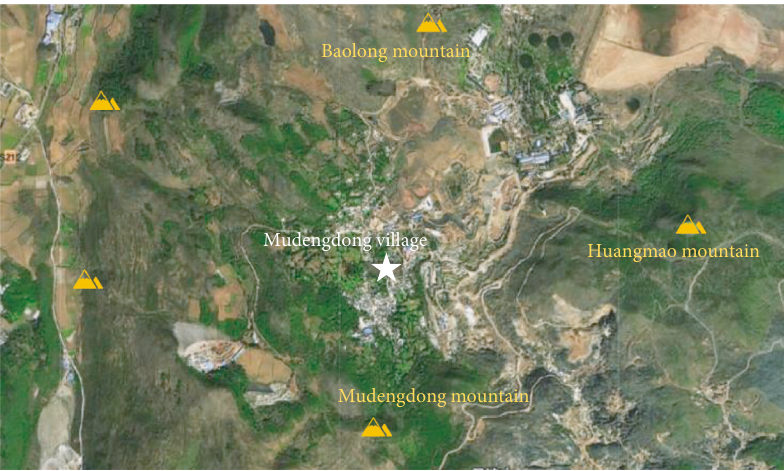
Figure 1: Geographical position of the Mudengdong